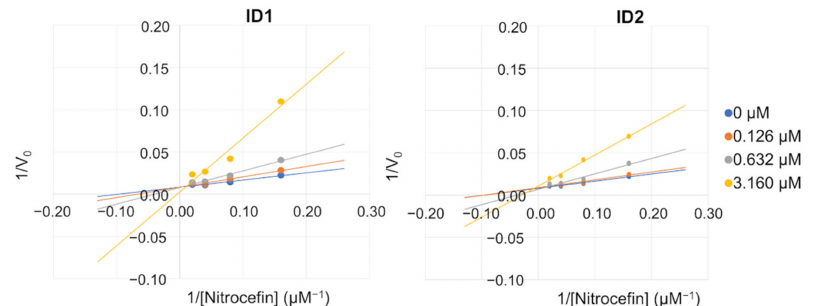
Figure 12. Lineweaver–Burk plots showing competitive inhibition of OXA-48 with respect to nitro- cefin using ID1 and ID2 . Inhibitor concentrations were 0 (blue), 0.126 (orange), 0.632 (grey), and 3.160 µ M